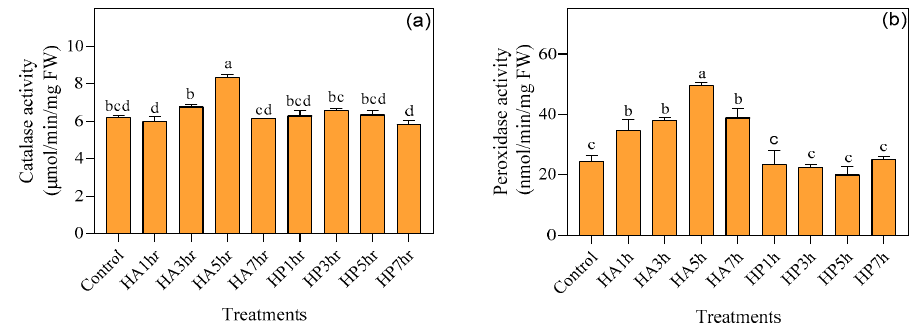
Figure 7. Effect of priming treatments on ( a ) catalase activity (CAT), ( b ) peroxidase activity (POD) and means (±SE) followed by the same letter on the bar do not differ significantly based on LSD at p < 0.05.